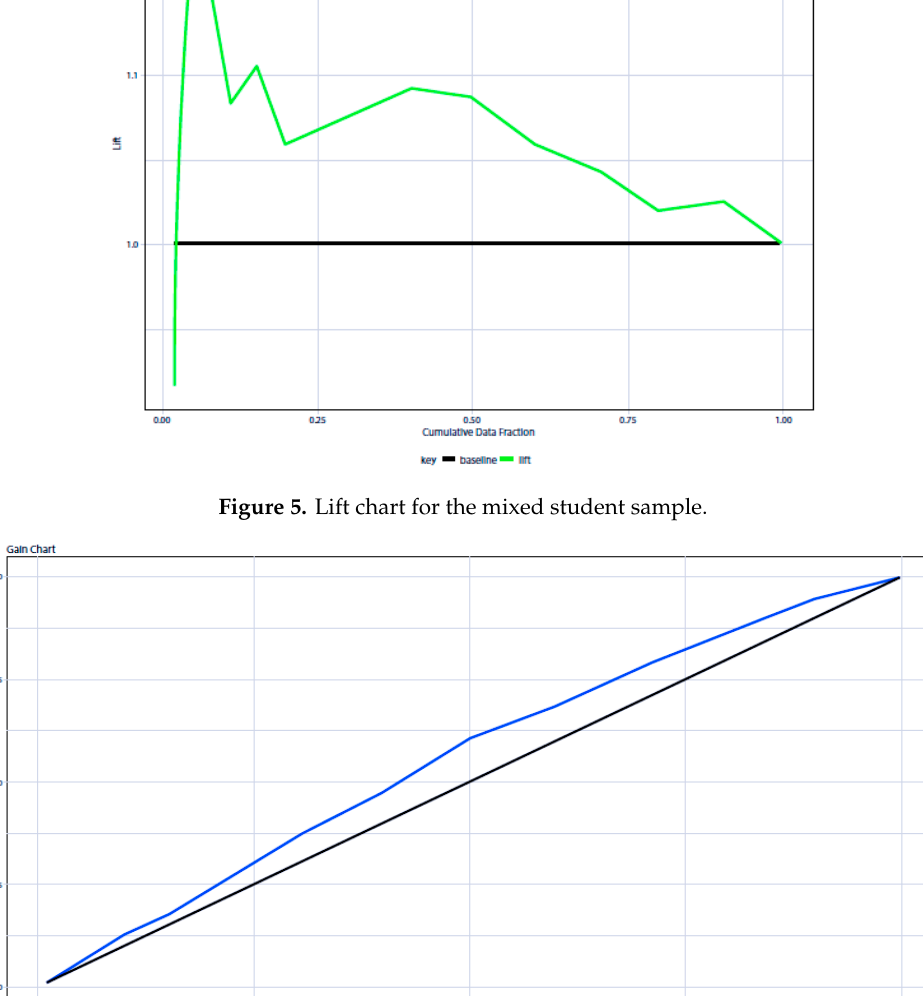
Figure 6. Gain chart for the male students’ sub-sample.